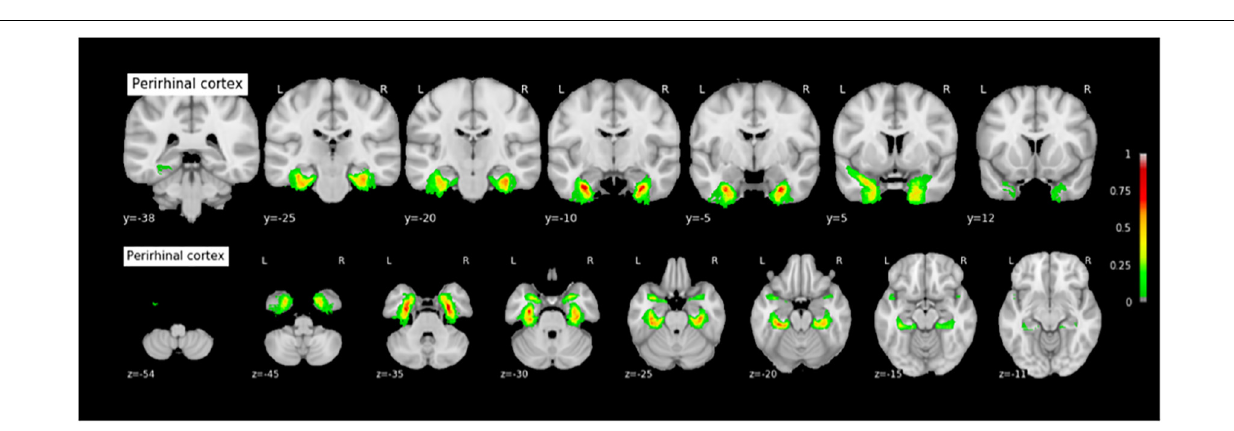
FIGURE 9 | Probabilistic map of the perirhinal cortex (PRC). The maps are normalized into the MNI stereotaxic space. Coordinates are indicated on each